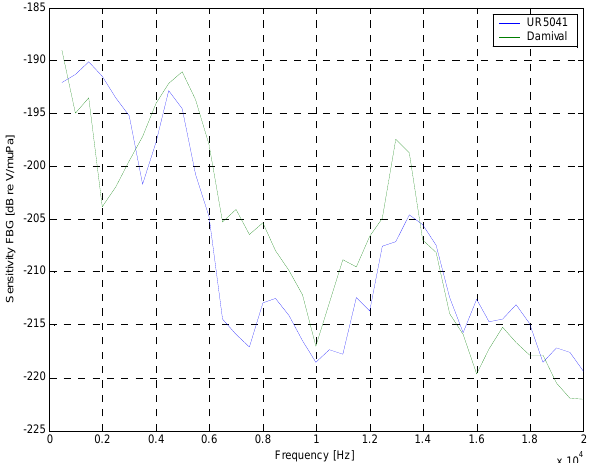
Figure 7 . Frequency response of the FBG hydrophones coated with Damival and